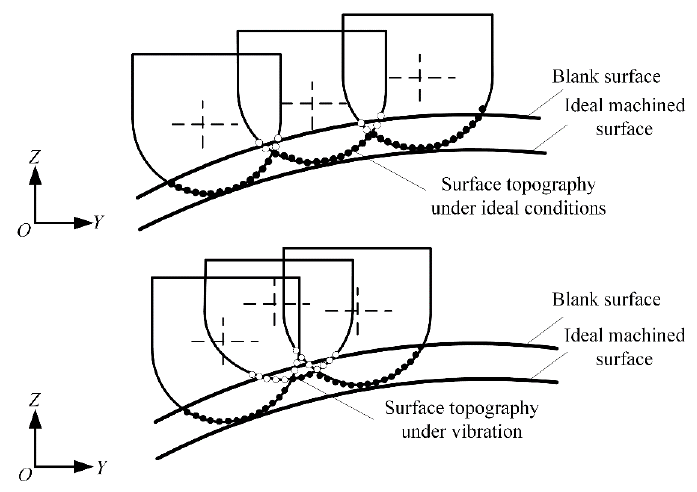
ff ect of vibration on surface Figure 15. Schematic diagram of the effect of vibration on surface topography. Figure 15. Schematic diagram of the e